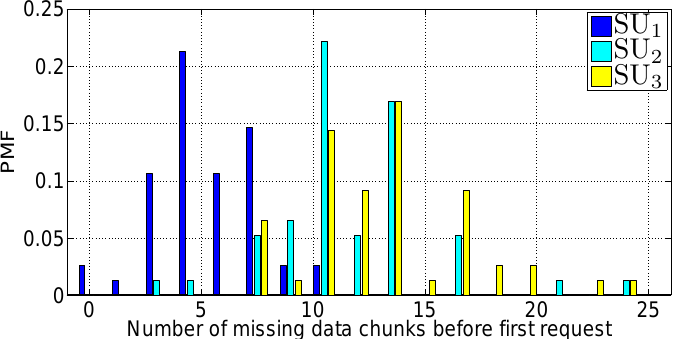
Figure 18. PMF of missing DATA chunks, before first REQUEST round in Scenario 2.